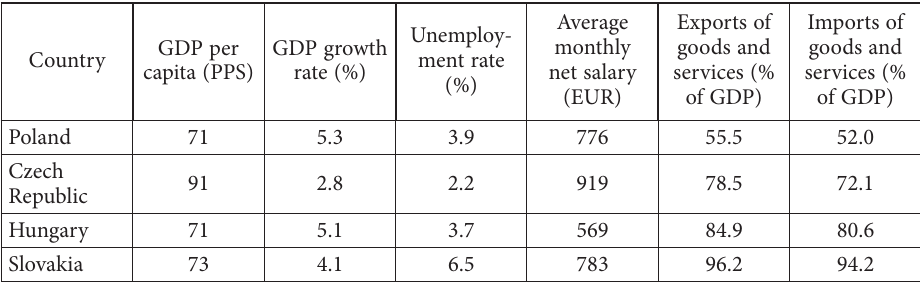
Table 1. The selected macroeconomic indicators for V4 economies in